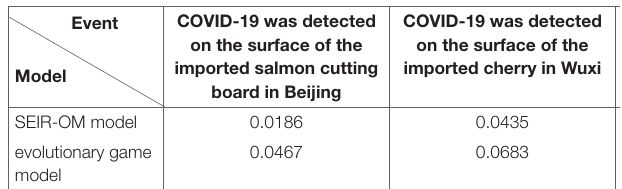
TABLE 6 | RMSE of rumor diffusion